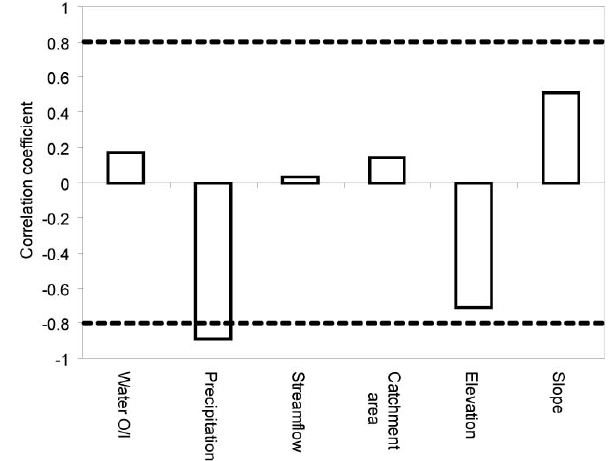
Fig. 7. Pearson correlation coefficient between chloride O/I and each of the six selected climate and catchment variables for all type VI catchments (Table 3). The dash lines are statistically significant linear correlation at 95% confidence level, showing that only pre- cipitation is significantly correlated to chloride O/I